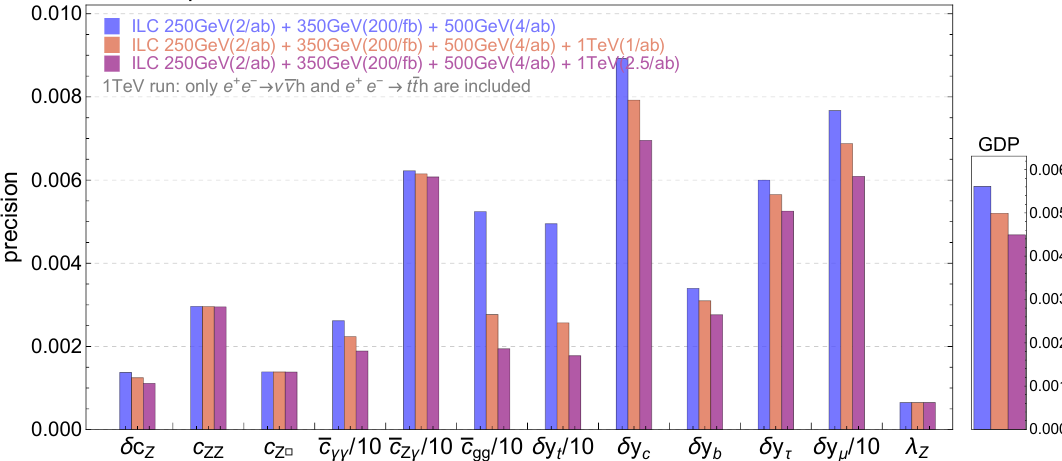
Figure 17 . The precision reach for ILC with di(cid:11)erent scenarios for the 1 TeV run. The 1st column corresponds to the ILC full run considered in our study with 2 ab (cid:0) 1 at 250 GeV, 200 fb (cid:0) 1 at 350 GeV and 4 ab (cid:0) 1 at 500 GeV and a (cid:12)xed polarization of P ( e 2nd (3rd) column, an additional run at 1 TeV with an integrated luminosity of 1 ab (cid:0) 1 (2 : 5 ab (cid:0) 1 ) + ) = ( and polarization P ( e 0 : 8 ; +0 : 2) is also included. For the 1 TeV run, the estimated (cid:0) ; e (cid:0) measurement precisions in ref. [59] are used. Only the measurements of the e + e e + e (cid:0) t (cid:22) th processes are included at 1 TeV, as the ones for e + e (cid:0) !